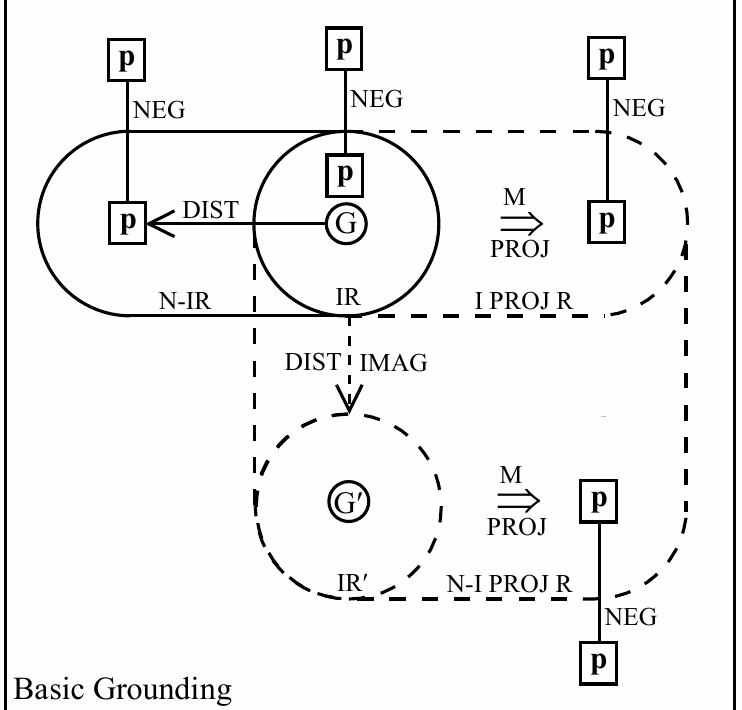
Figure 8. The basic grounding system with negation.